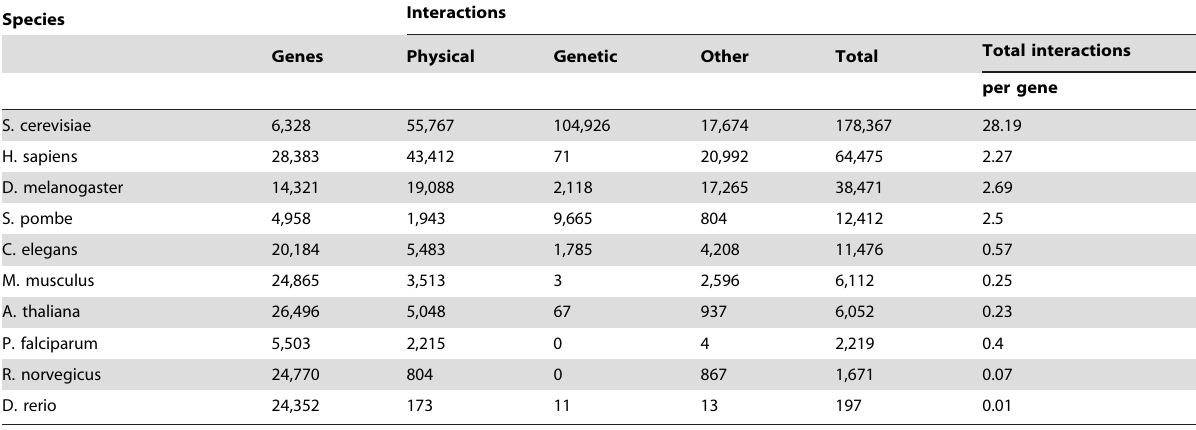
Table 1. Protein interaction